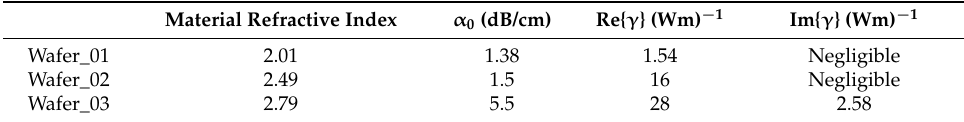
Table 6. Extracted optical characteristics for different silicon ‐ rich silicon nitride material compositions.